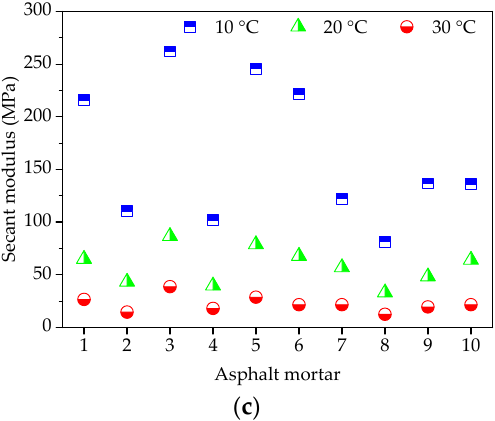
Figure 4. Failure results of asphalt mortars: ( a ) Failure stress; ( b ) Failure strain; and, ( c ) Secant modulus.